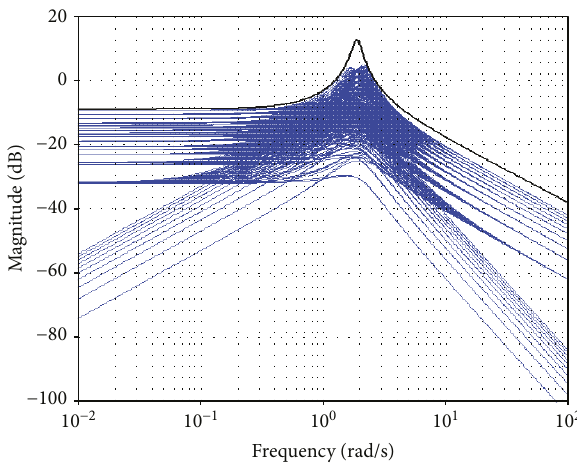
Figure 7: Bode magnitude plots — set of FO normalized perturbations and weight function (26) for the multiplicative uncertainty model [55].